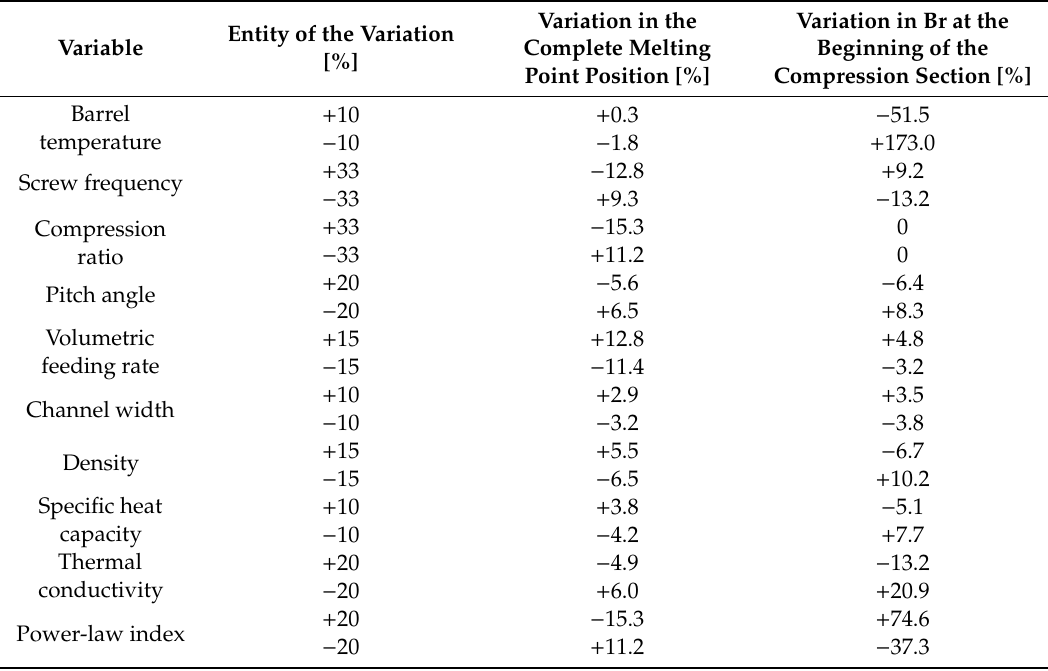
Table 2. Overview of individual e ff ects for finalization